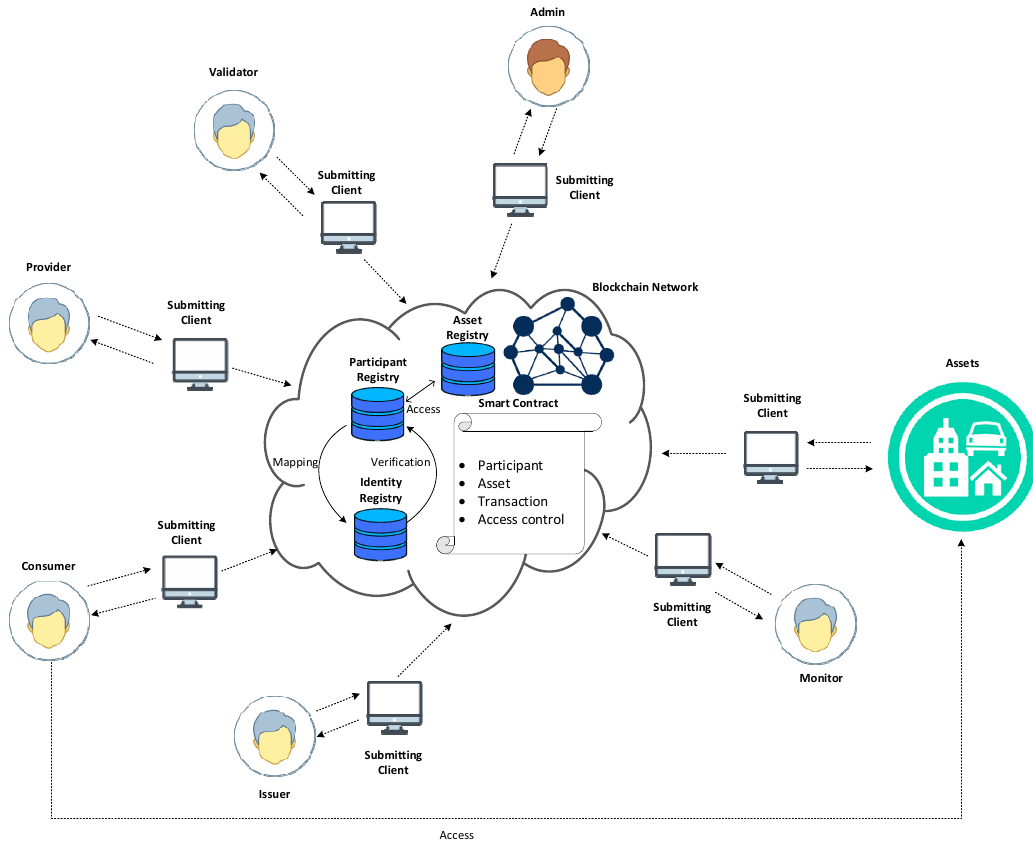
Figure 2. Proposed sharing economy service interaction diagram.